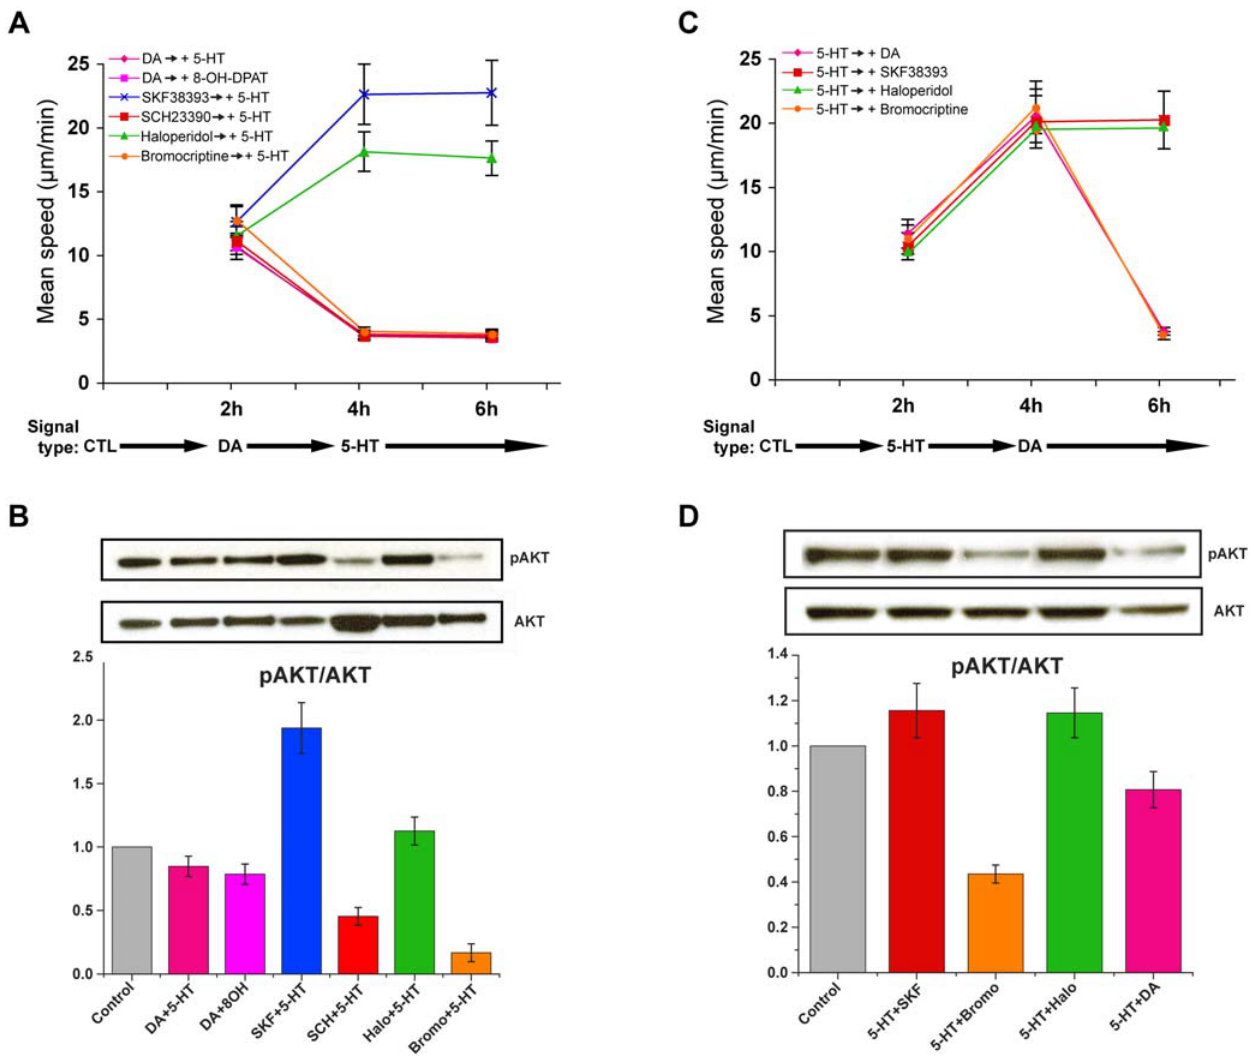
Figure 8. Treatment with IBMX has different effects on hippocampal neurons and striatal neurons (A–C). A. Inhibition of mitochondrial movement by IBMX. Mean speed ( m m/min) of all directionally moving mitochondria from pooled experiments before and after treatment with IBMX (100 m M; n=5, paired t -test; p , 0.02). B. Western blot analysis shows that administration of IBMX (100 m M) reduces Akt activity in hippocampal neurons, which is represented by decreased levels of phosphorylated serine-473 of Akt, relative to total Akt, over time. C. Western blot analysis